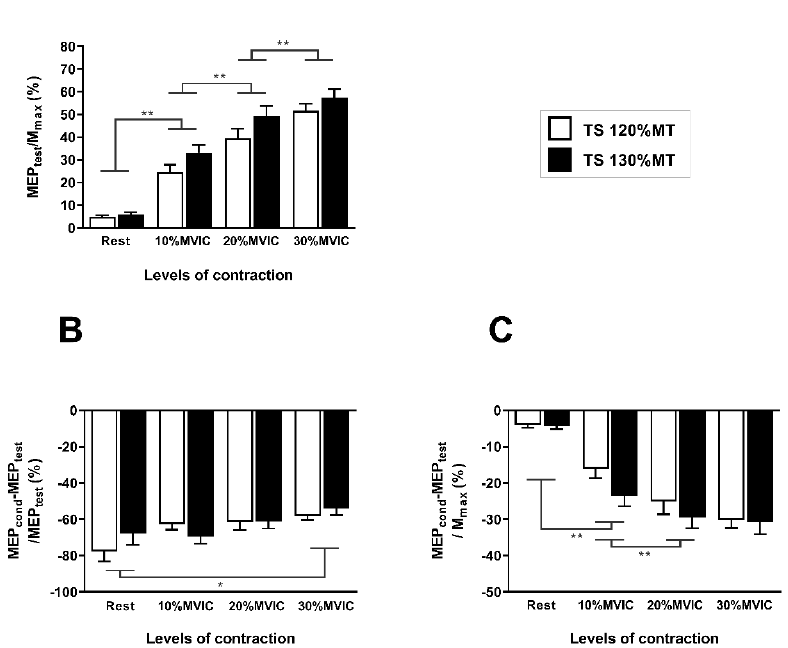
Figure 4. ( A ) MEP test / Mmax ratios according to the TS intensity and the levels of contraction. ( B ) Short-interval intracortical inhibition (SICI) expressed as percentage of MEP test (SICI MEPtest ) according to the TS intensity and the levels of contraction. ( C ) SICI expressed in percentage of Mmax (SICI Mmax ) according to the TS intensity and the levels of contraction. * p < 0.05; ** p < 0.001. Table 2. Regression analysis between MEP test / Mmax ratio (independent variable) and SICI Mmax (dependent variable) estimated individually for each subject. Individual slopes, intercept, R 2 , p values and range of the MEP / Mmax ratios were extracted and